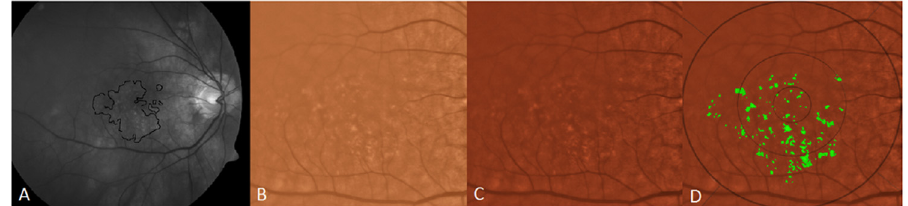
Fig 2. Illustration of drusen segmentation methods. A) Red-free fundus photo. Areas with drusen are circled in black (human supervision) to initialize the segmentation program. This allows the program to exclude from consideration peripapillary changes and other hypo-pigmented or hyper-reflective non-drusen features, resulting in a more rapid and accurate drusen identification. B) original color fundus photograph, cropped to 6 mm field C) contrast-enhanced color photograph D) contrast-enhanced color photograph with superimposed Wisconsin grading template (6 mm diameter circle with central, middle and outer subfields of diameters of 1, 3 and 6 mm). Drusen have been automatically segmented in detail (green) by the custom software within the areas containing drusen identified in